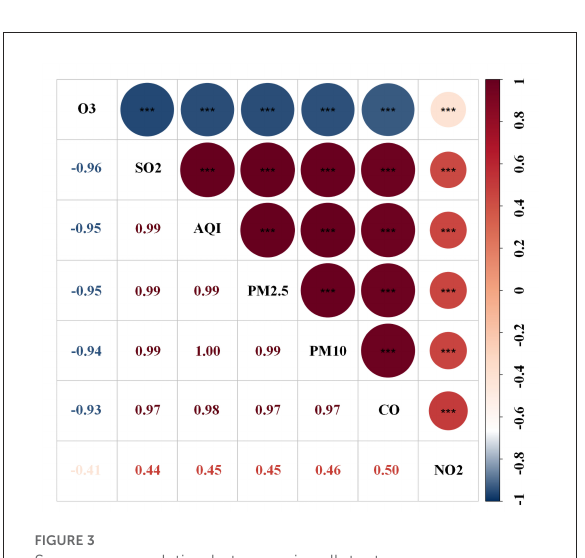
AQI, PCA score and combined score were 0.713, 0.715, and 0.715, respectively. Their calibration curves are also similar (Supplementary Figure